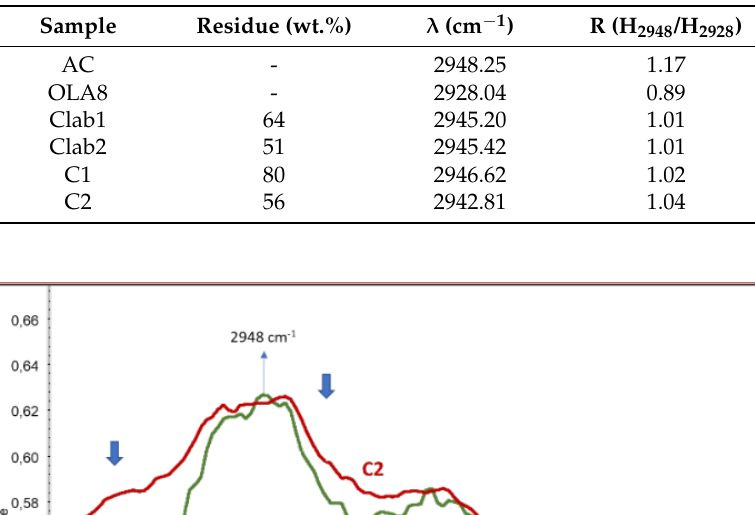
(Figure 4). In fact, the spectrum profile of the modified AC is different from the one of pure cellulose acetate because of the superposition of the grafted OLA signals, determining an increase of the absorbance at 2928 (asymmetric stretching of C-H in CH 2 groups of OLA) and at about 2990 cm − 1 (asymmetric stretching of C-H in CH 3 groups of OLA). Table 1. FT-IR analysis of C1 and C2, the AC/OLA based prepared compatibilizers. Compositions of C1 and C2 are reported in the experimental part.